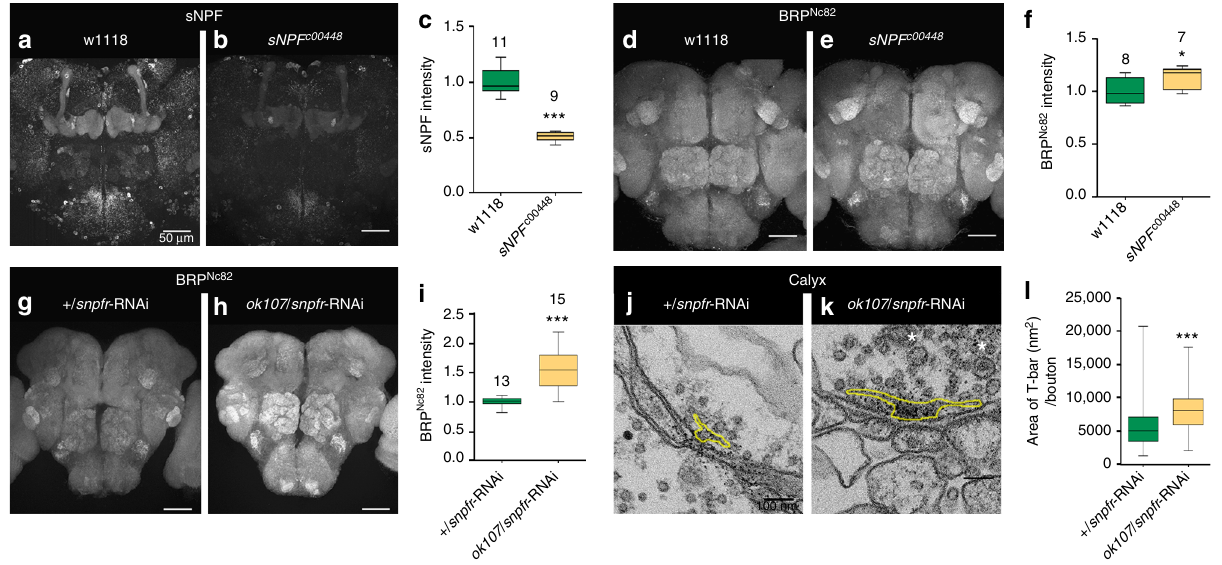
Fig. 6 sNPF signaling connects autophagy suppression with presynaptic metaplasticity. Adult brain, 5 days, ( a ) w1118 and ( b ) sNPF c00448 immunostained for sNPF peptide precursor. Scale bar: 50 μ m. c Quanti fi cation of sNPF peptide precursor within the central brain region normalized to control fl ies. ( n = 9 – 11 independent brains; *** p < 0.001; Mann – Whitney U -test). Adult brain, 5 days, ( d ) w1118 and ( e ) sNPF c00448 fl ies, immunostained for BRP Nc82 . Scale bar: 50 μ m. f Quanti fi cation of BRP Nc82 within the central brain region normalized to control fl ies ( n = 7 – 8 independent brains; * p < 0.05; Mann – Whitney U -test). Adult brain, 5 days, ( g ) + / snpfr -RNAi and ( h ) ok107 / snpfr -RNAi fl ies, immunostained for BRP Nc82 . Scale bar: 50 μ m. i Quanti fi cation of BRP Nc82 within the central brain region normalized to control fl ies ( n = 13 – 15 independent brains; *** p < 0.001; Mann – Whitney U -test). Electron micrograph showing presynaptic specializations at PN-to-KC synapses in Calyx of ( j ) + / snpfr -RNAi and ( k ) ok107 / snpfr -RNAi animals. Scale bar: 100 nm. l Quanti fi cation representing the average T-bar size in + / snpfr -RNAi and ok107 / snpfr -RNAi animals ( n = 206 electron micrographs across eight independent animals, with at least 20 T-bars per animal; *** p < 0.001; Mann – Whitney U -test). In the box and whisker plots, the middle line of a box represents the median (50th percentile) and the terminal lines of a box represent the 25th and 75th percentile. The whiskers represent the lowest and